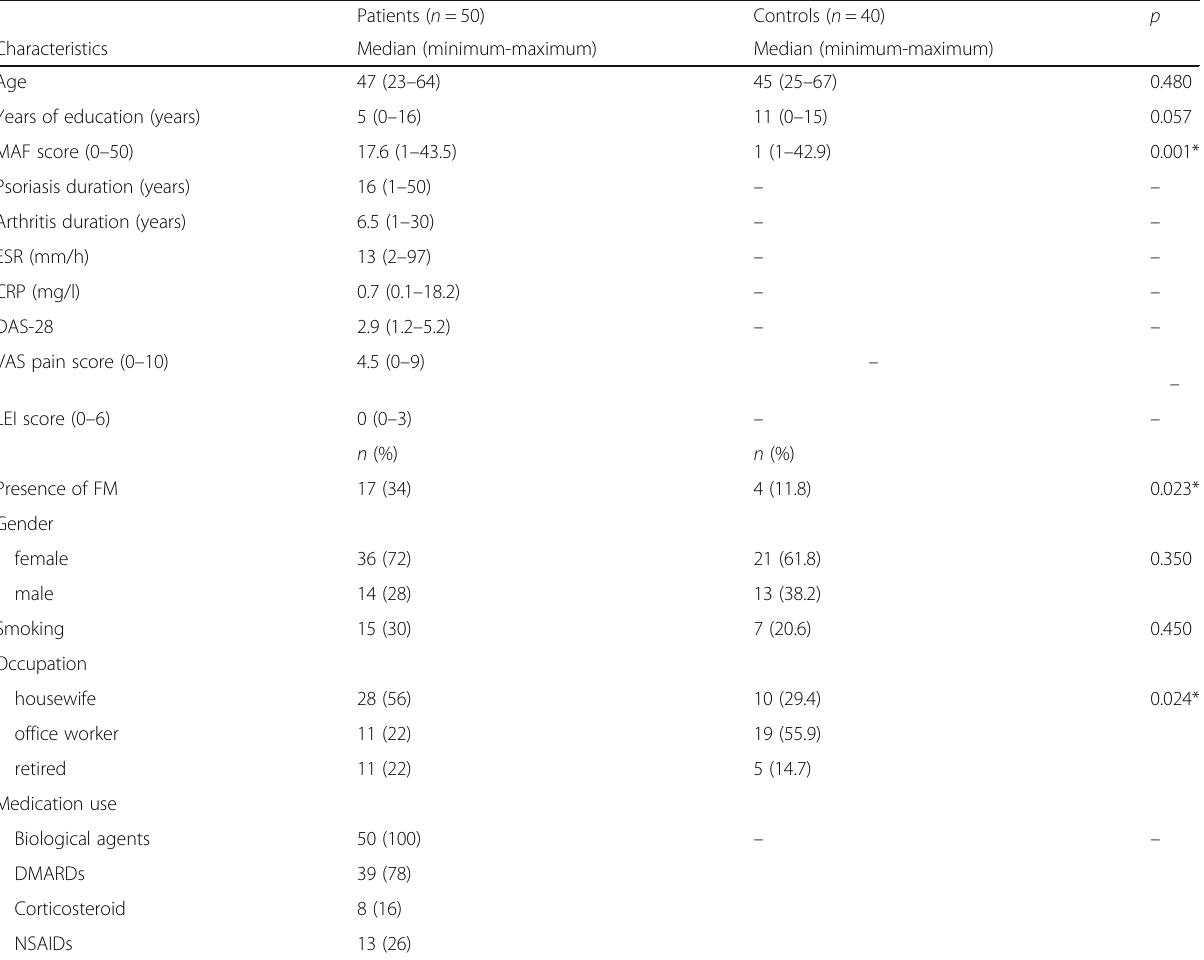
Table 1 Comparison of demographic and clinical characteristics of the patients with psoriatic arthritis and controls Patients ( n =